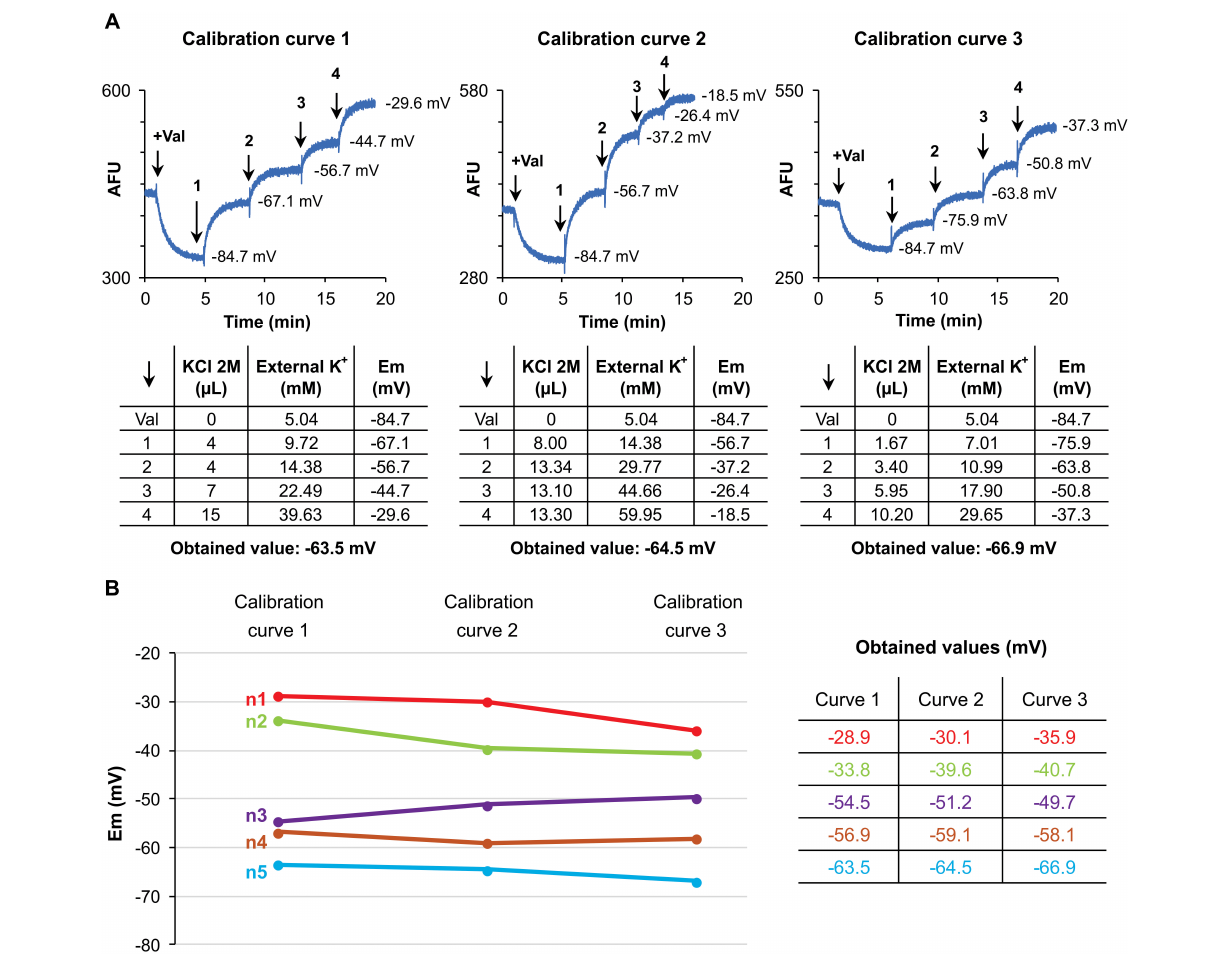
FIGURE 2 | Calibration of Em measurements. (A) Upper panels show fluorescence traces for each calibration curve tested (1–3), indicating Em values after sequential KCl additions. Lower panels show KCl volume added, external K + concentration and Em obtained for each addition. Finally, the resting membrane potential of each measurement is indicated. (B) Membrane potential values obtained after testing the described calibration curves in five different samples. No significant differences were observed, p >